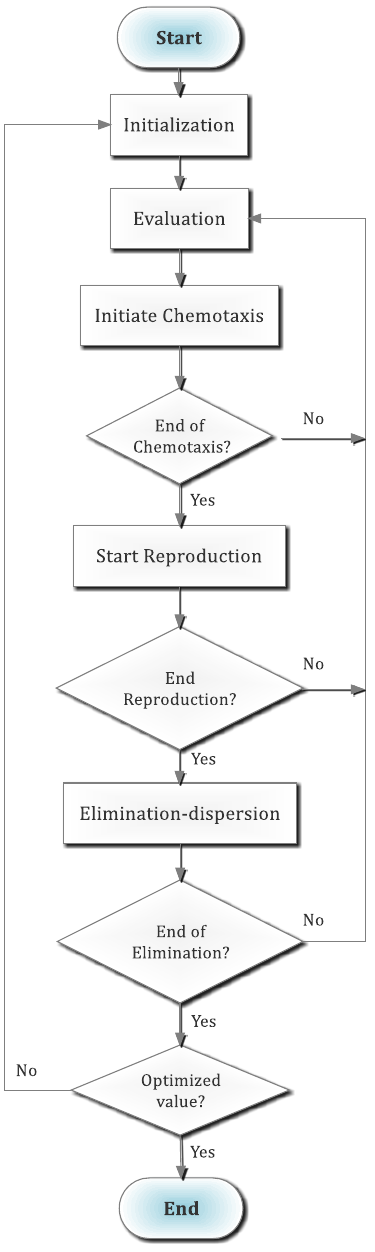
Figure 2. Flowchart for bacteria foraging optimization.